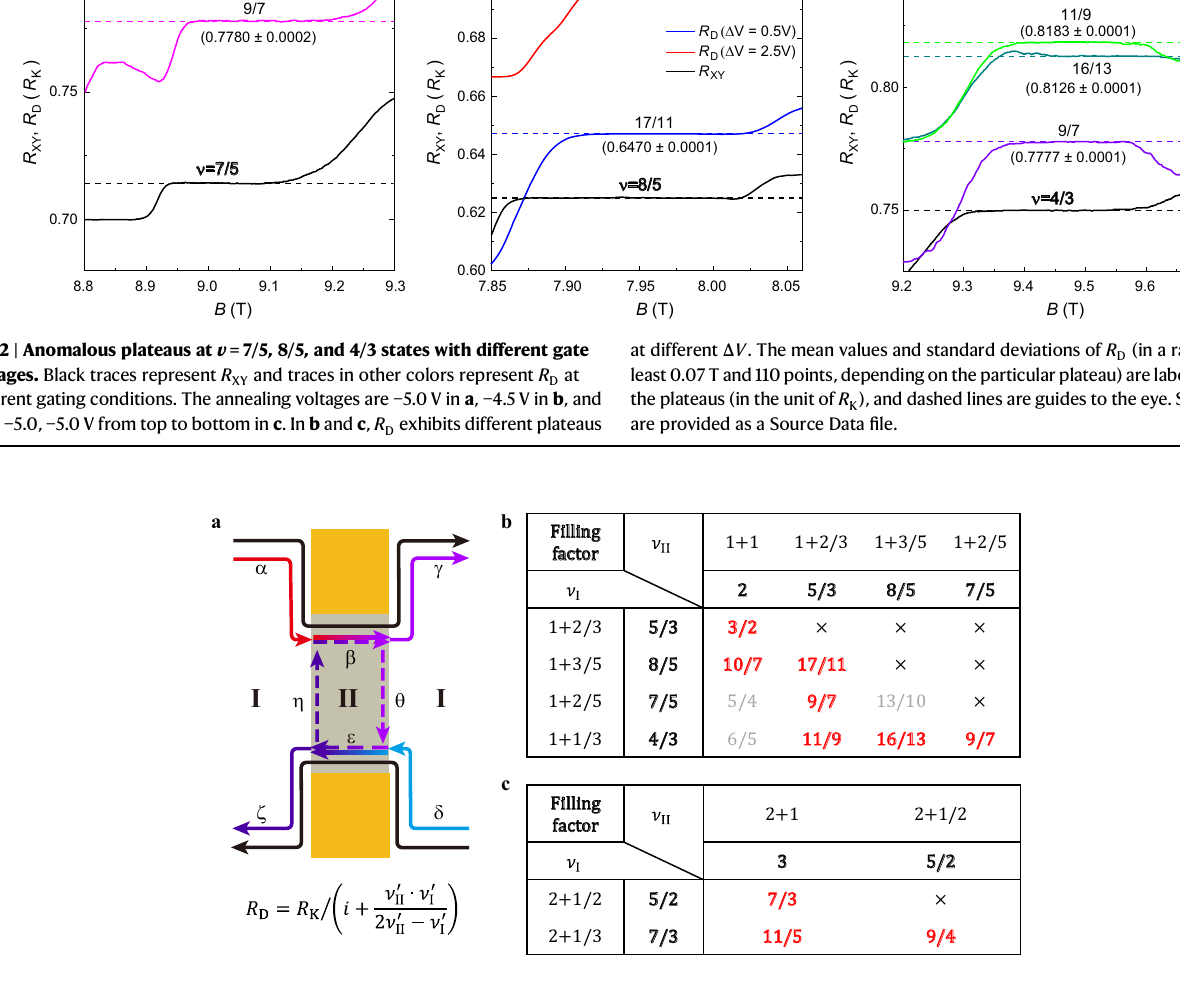
Fig. 3 | Sketch of edge modes propagation inside and outside the con fi ned region and predicted plateaus in 1< v ≤ 2 and 2< v ≤ 3. a Black arrows represent outer edge modes that each contributes to e 2 = h , while arrows in other colors represent inner edgemodes contribute to a fraction (<1) multiples e 2 = h . Red color ( α ) represents the highest chemical potential of the inner edge modes, while blue color ( δ ) represents the lowest chemical potential. Region I represents the open